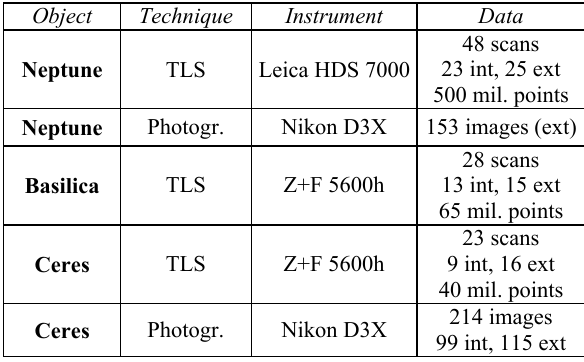
Figure 3: TLS data acquisition, clouds and produced 3D model (above). Terrestrial image-based network and derived 3D data (below). Table 2. Terrestrial surveying of the archaeological monuments in